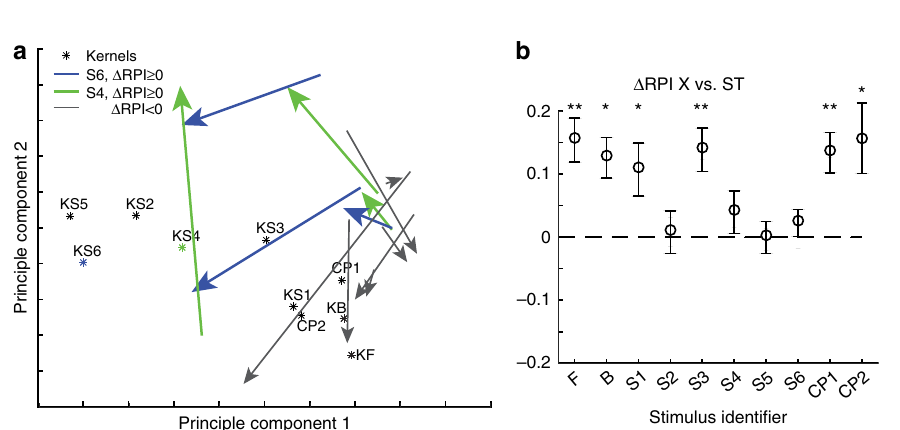
Fig. 6 Relationship between changes in visual selectivity and parameters related to animal maturity. a Animal age, days after eye-opening. ST indicates animals trained with S4, S6. Triangles indicate animals from ref. 17 trained with bidirectional moving stimuli. Filled circle is single animal beyond critical period for direction selectivity development. b Animal age, initial orientation selectivity (1-CV). On average, orientation selectivity becomes stronger with age, but there is range of initial selectivity in youngest animals, likely re fl ecting range of cortical maturity achieved. c Difference in RPI for F vs trained stimulus (denoted ST ; S4 or S6) before and after training (error bars 95% con fi dence intervals) plotted against days after eye-opening ( ρ = − 0.43, p < 0.165, DF = 12-2). d Same, but difference in direction index values ( ρ = 0.54, p < 0.068, DF = 12-2). e Difference in RPI vs initial orientation selectivity that was measured at beginning of the experiment (before training stimulus exposure). Animals with lowest orientation selectivity exhibit strong changes in RPI, become more selective for scrambled training stimulus. ρ < 0* indicates signi fi cant negative correlation ( ρ = − 0.71, p < 0.009, DF = 12-2). f Same, but for DI ( ρ = 0.44, p < 0.152, DF = 12 - 2). g Left: Changes in RPI (F vs training stimulus ST) for animals whose eyes were opened by experimenter (EO < 1) and animals whose eyes opened naturally before experiment (EO ≥ 1). * Indicates signi fi cant difference, t -test (mean ± SEM EO < 1: 0.16 ± 0.05, EO ≥ 1: 0.00 ± 0.03, p < 0.020241, DF = 12-2). Right: Changes in RPI (F vs ST) for animals that exhibited low initial orientation selectivity (1-CV < 0.3) and animals that exhibited higher initial orientation selectivity (1-CV ≥ 0.3) * indicates signi fi cant difference, t -Test (mean ± SEM 1-CV < 0.3: 0.04 ± 0.10, 1-CV ≥ 0.3:: − 0.01 ± 0.03, p < 0.0045866, DF = 12-2). h Same as g , but change in direction index values indicated. Left: Difference is not signi fi cant (mean ± SEM EO <